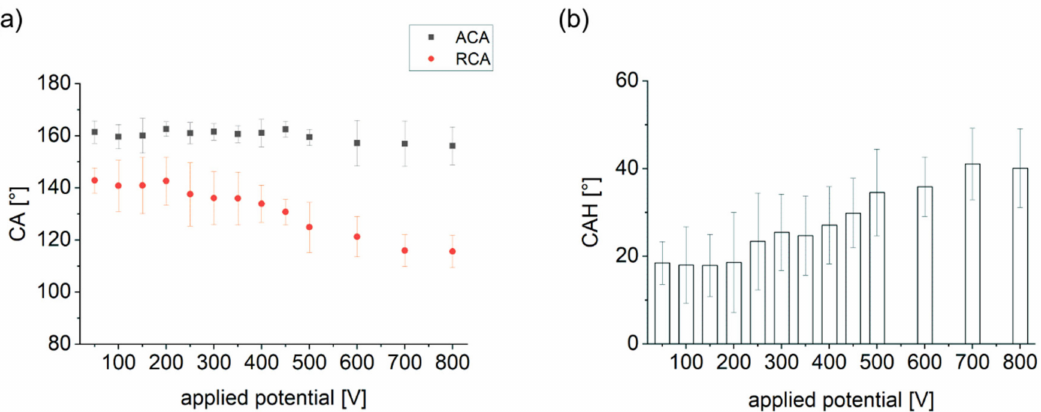
Figure 4. Measured advancing and receding CA (ARCA) and subsequent calculated CA hysteresis (CAH) in dependence of the applied voltage. ( a ) ARCA measurement revealed that with the increase of the potential the advancing CA (ACA, !) was stable while the receding CA (RCA) decreased. ( b ) This resulted in an increase of the